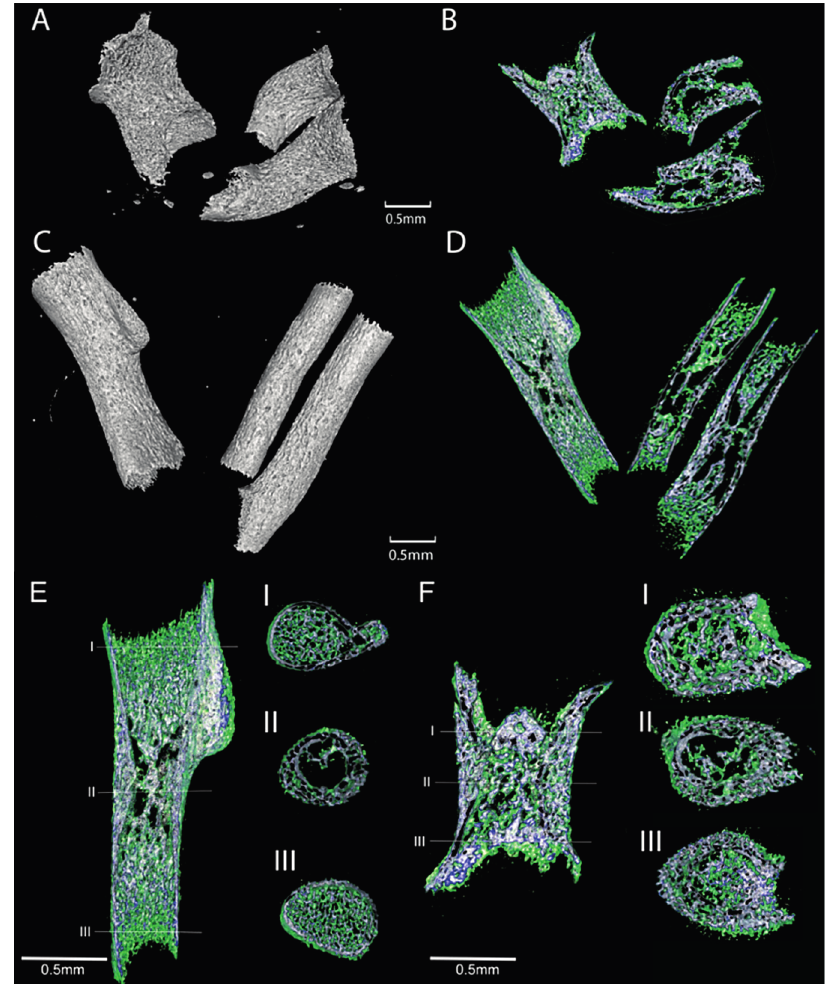
Figure 8. X-ray micro-CT images of forelimbs. ( A and B ) Col11a1-deficient mouse. ( C and D ) WT mouse; ( A ) Radius, ulna, and humerus of Col11a1-deficient mouse. The mineralized portions of the bones were shorter and wider in the Col11a1-deficient mice compared to ( C ) WT littermates (Table 3). Deltoid tuberosity was apparent in the WT humerus but absent in the Col11a1-deficient mouse. ( B and D ) Longitudinal cross-sections of each forelimb, shown in A and C, respectively. Mineralized tissue was assigned a color dependent upon three density ranges: low-density range (green), intermediate-density (blue), and high-density (white). Marrow space within the Col11a1-deficient limb showed regions of higher bone density near the proximal growth plates and those of very low density near the distal growth plates when compared to analogous regions in the WT littermate. ( E and F ) Cross-section of humeri at diaphysis, distal, and proximal metaphyses. ( E ) WT ( F ) Col11a1-deficient mouse. Col11a1-deficient humerus was wider and more cylindrical than WT. Mineralized tissue was assigned a color dependent upon three density ranges: low-density range (green), intermediate-density (blue), and high-density (white). Trabecular bone was denser in Col11a1-deficient mice compared to WT at proximal metaphysis. Trabecular bone is less dense in Col11a1-deficient mice compared to WT at distal metaphysis. Bone collar is less dense but thicker in Col11a1-deficient mice compared to WT littermate. Scale bars = 0.5